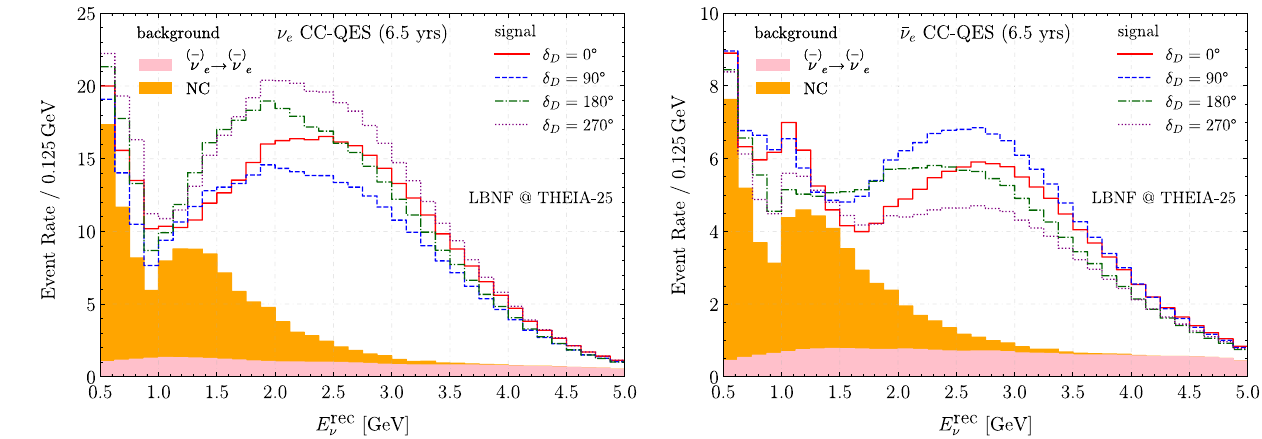
Fig. 9 The LBNF CC-QES signal (lines) and background (filled regions) event spectra as functions of the reconstructed neutrino energy E rec ν at the THEIA-25 detector. Both neutrino (left) and anti-neutrino (right) modes are shown, each with 6.5 years running. The signal curves